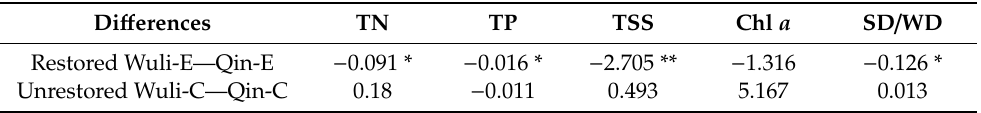
Table 3. Pairwise comparisons of the concentrations of total phosphorus (TP), total nitrogen (TN), total suspended solids (TSS), chlorophyll a (Chl a ) and SD / WD (Secchi depth: water depth ratio) in restored lake areas (Wuli-E and Qin-E) and the unrestored areas (Wuli-C and Qin-C) after restoration through estimating marginal means (adjusted by Bonferroni’s